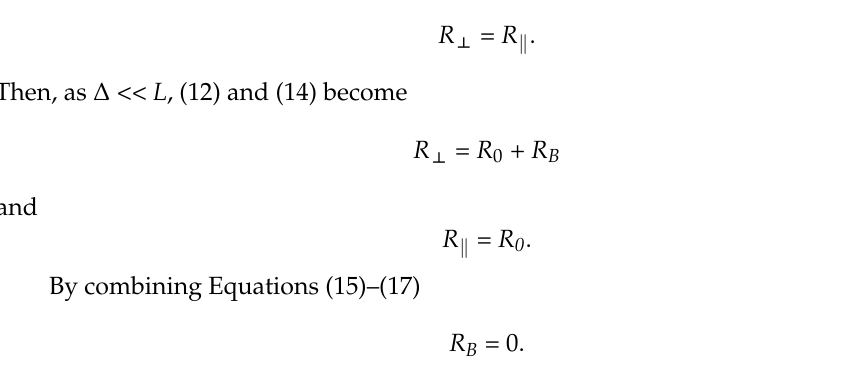
Figure 6. Optical micrograph of the TFT fabrication: ( a ) after the island patterning and ( b ) after the gate patterning. The channel length was 10 μ m with a width of 5 μ m for both parallel and perpen ‐ dicular TFTs.